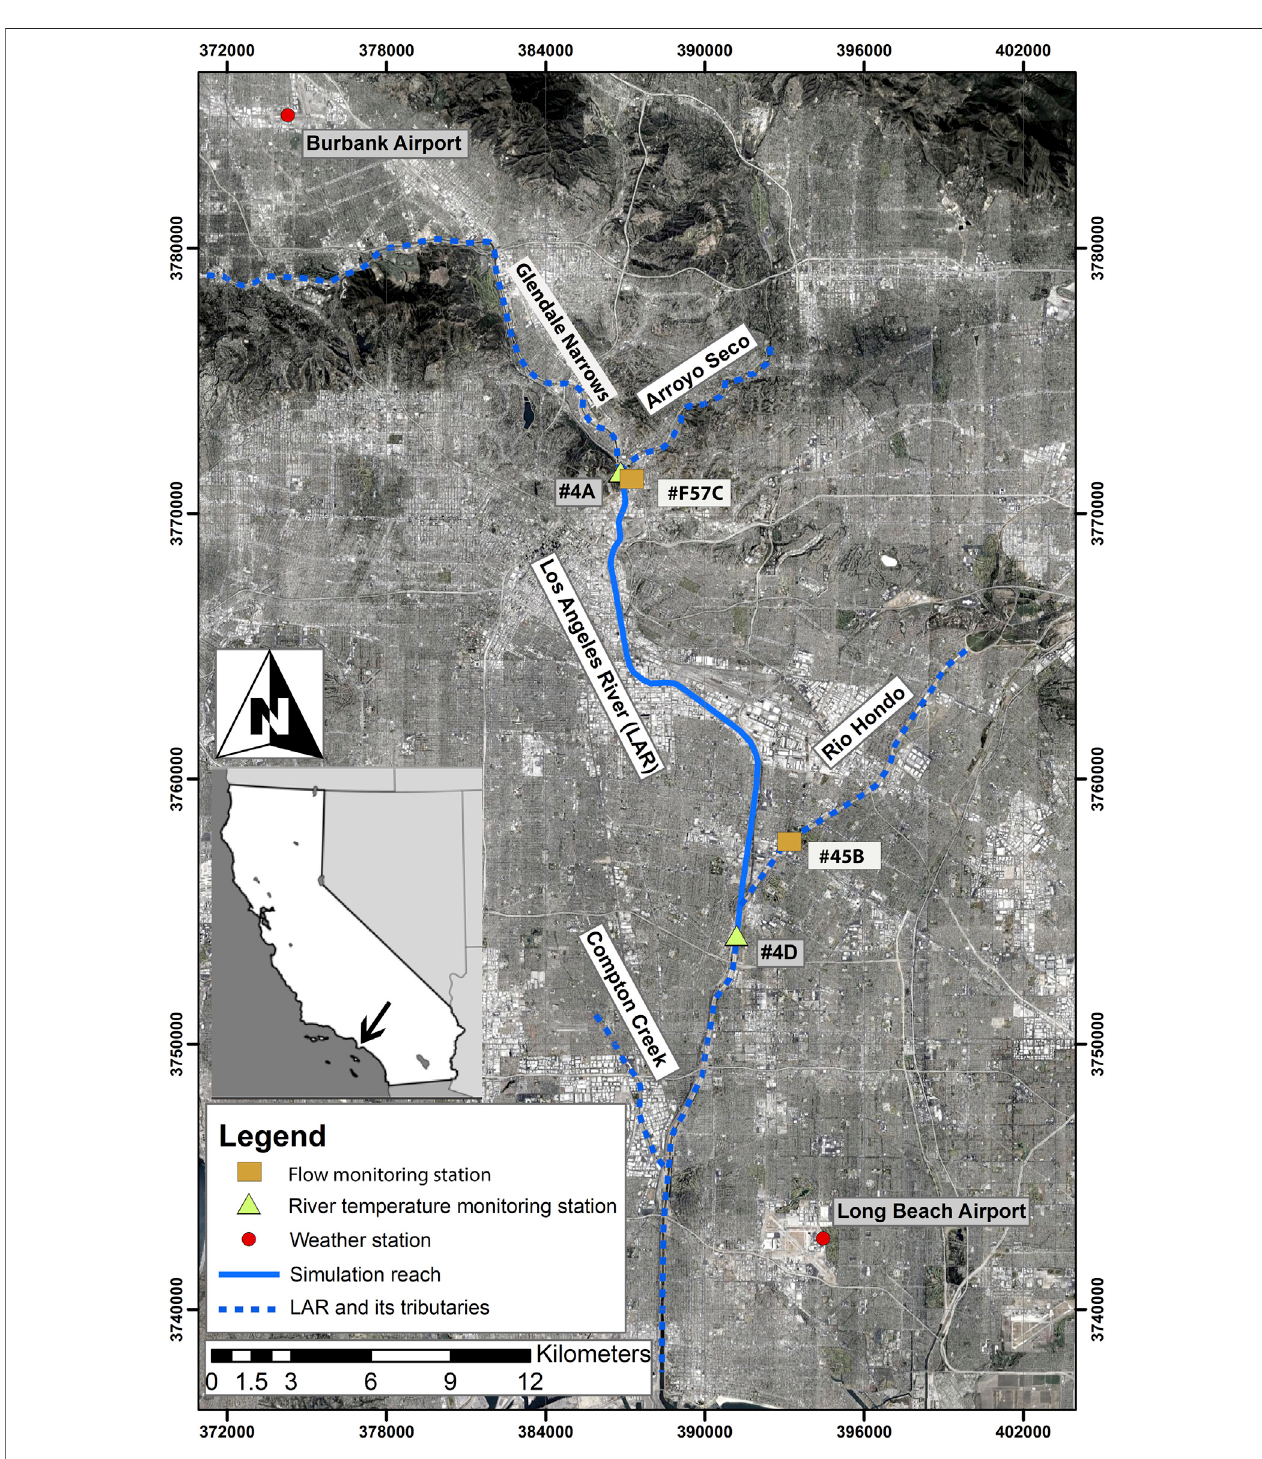
FIGURE1 | Study area on LAR ’ s mainstem.The fi gure includes the weather stations and river temperature monitoringstations aswell the fl ow monitoring stations that are represented by the arrows The inset with an arrow shows the site location within the state of California, United States.